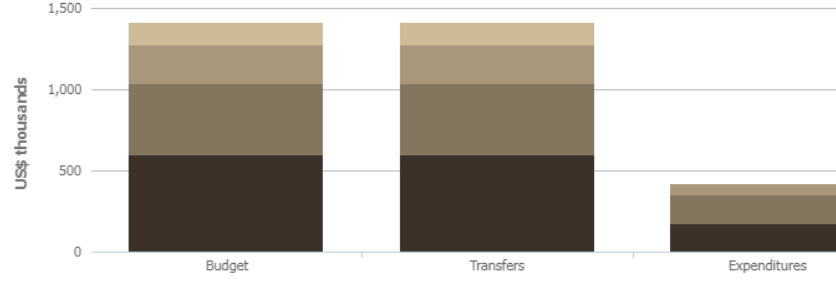
Figure 3: Budget Utilization (Source: MPTF UNDP